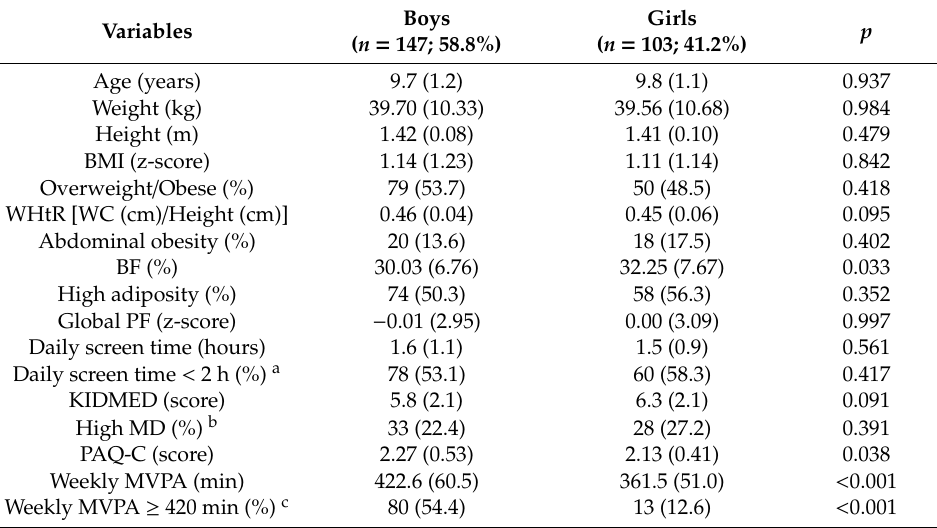
Table 1. Descriptive data of the sample stratified by